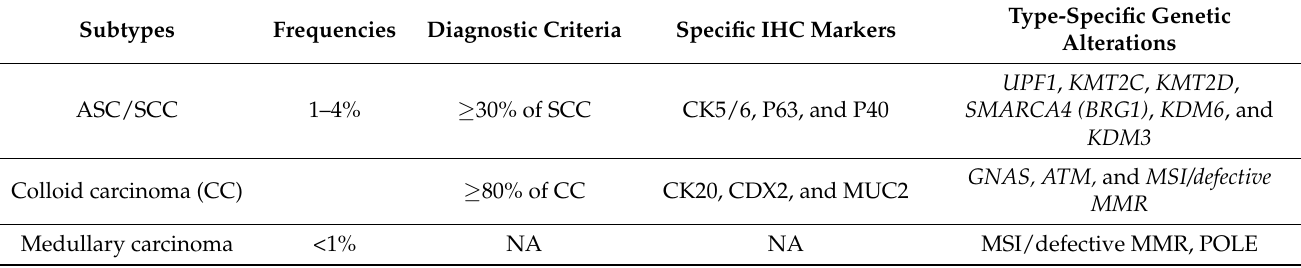
Table 1. The subtypes of pancreatic ductal adenocarcinoma and their associated molecular